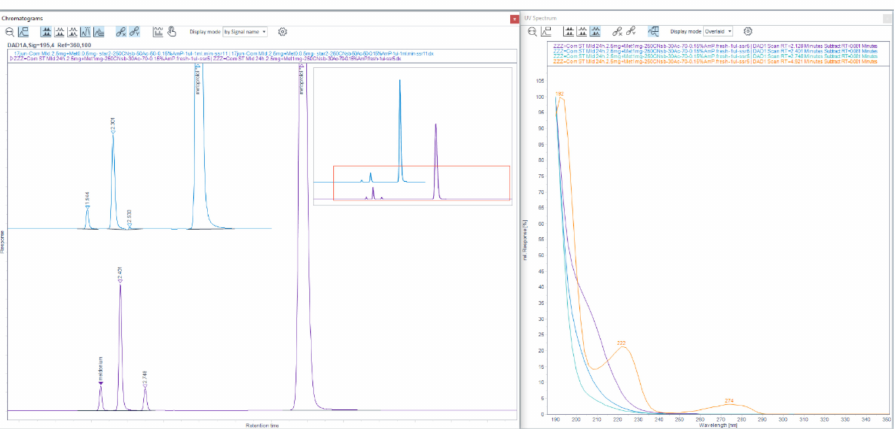
Figure 39. Chromatograms, obtained by usage ACN content to 50% (upper chromatogram) and with 30% ACN (bottom chromatogram) with of 13 mM NH 4 H 2 PO 4 . Chromatograms were presented in full and expanded overlaid sizes, with UV-abs spectrum extracted at